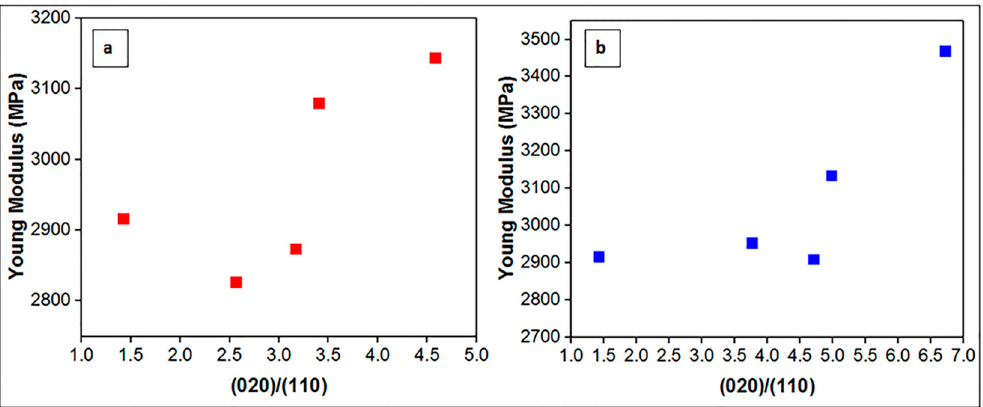
Figure 11. Young’s modulus variation with (020)/(110) relative intensity ratio of ( a ) PHBV/OSBN and ( b ) PHBV/OSFBN composites